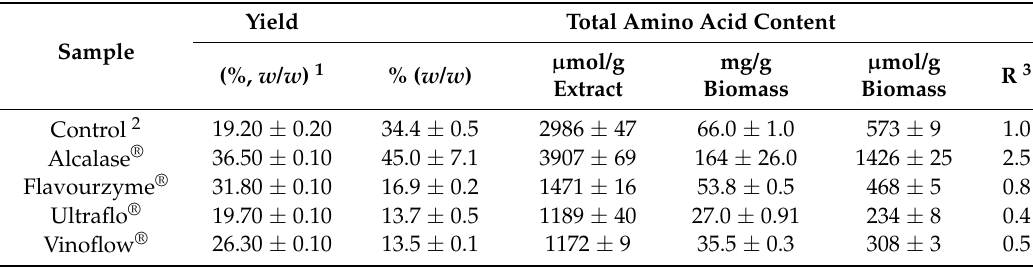
Table 1. Extraction yield and total content of amino acids of the aqueous extracts obtained with the enzyme-assisted and control extraction procedures in their respective optimal operation conditions.